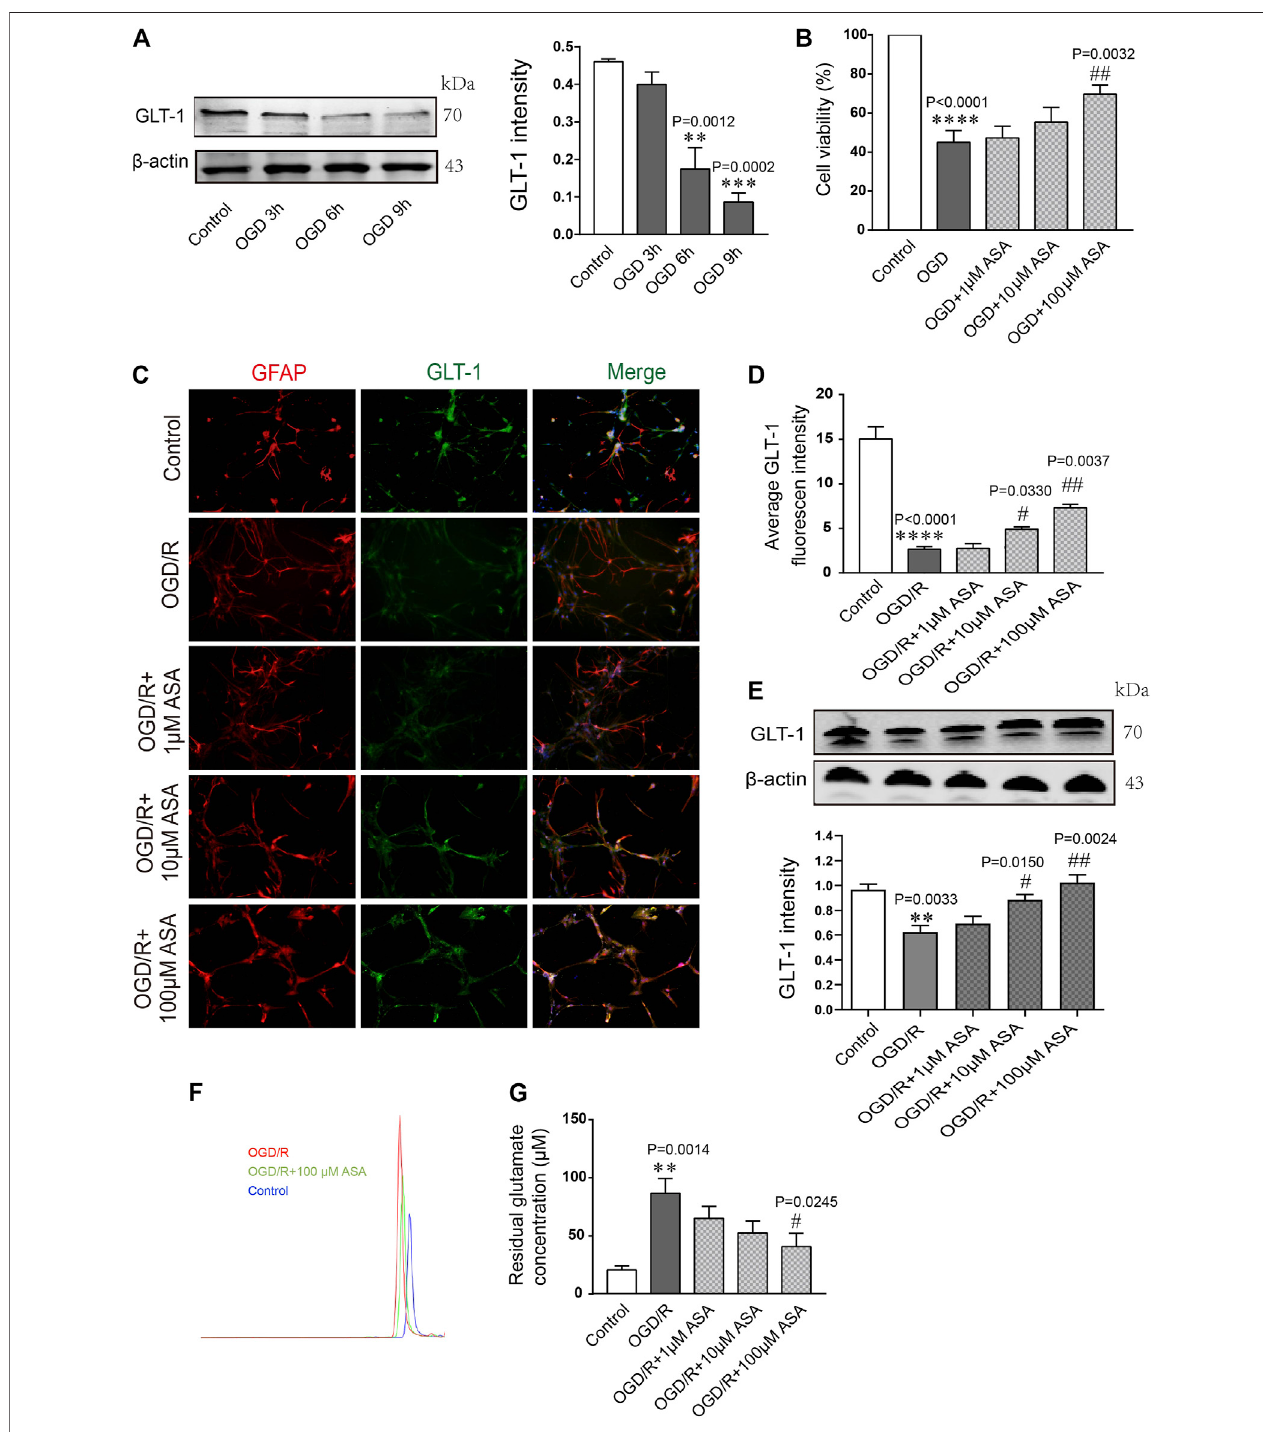
FIGURE 6 | α -Asaronol increases the expression of astrocytic GLT-1 under OGD/R conditions. (A) Gradient OGD/R conditions of astrocytes. (B) Cell viability of astrocytes. (C) Representativeimmuno fl uorescenceimagesforGFAPandGLT-1staininginthecorpuscallosumforallgroups.Scalebar,20 µm. (D) Statisticalanalysis of GLT-1 mean fl uorescence intensity. (E) The expression of GLT-1 was detected and quanti fi ed. (F,G) Chromatographs of glutamate and quantitative analysis of glutamateconcentrationinthemediumforallgroupswereperformed.Alldataarerepresentedasthemean±SEM.** p < 0.01,**** p < 0.0001vs.thecontrolgroup, # p < 0.05, ## p < 0.01 vs. the OGD/R group. N = 4 for each group.